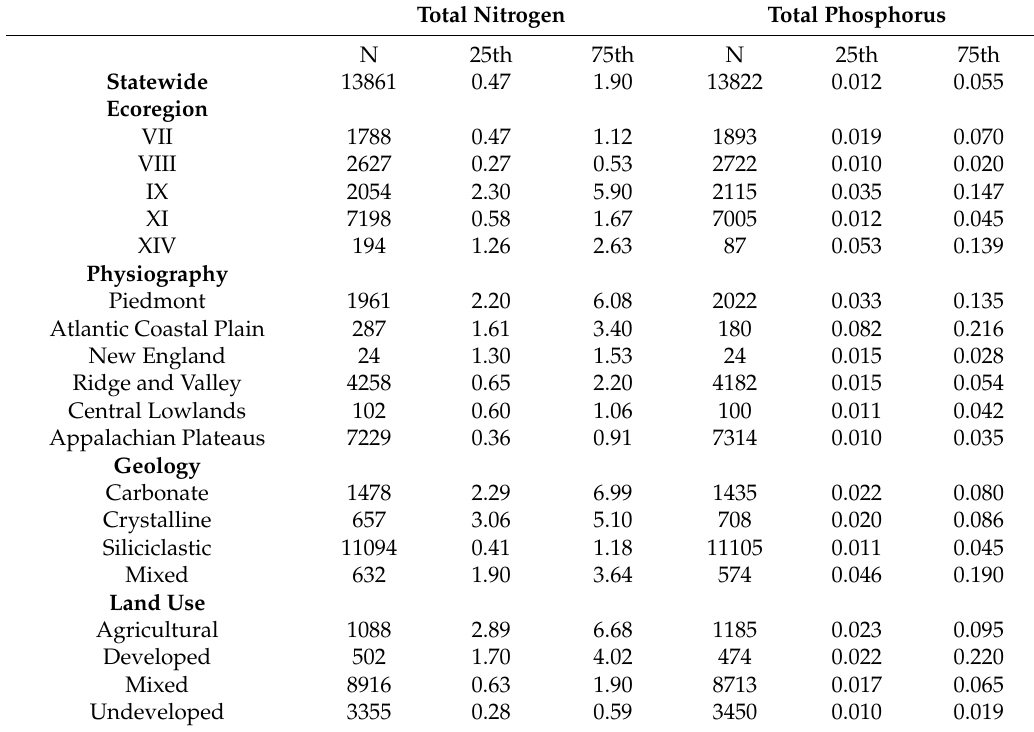
Table 1. Percentile values (25th and 75th) of median nutrient concentrations for total nitrogen (mg N / L) and total phosphorus (mg P / L) observed at stream monitoring sites from 2000 to 2019, for major ecoregions, physiographic provinces, geological settings, and land uses across Pennsylvania.